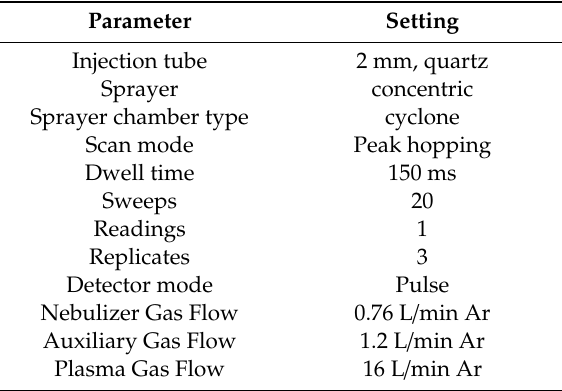
Table 2. Mass spectroscopy (ICP-MS)